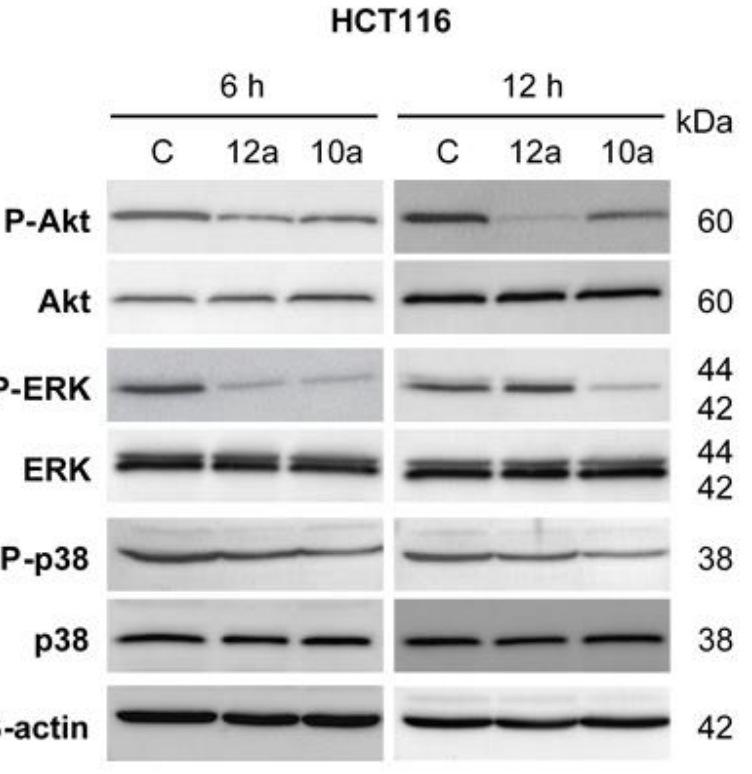
Figure 5. Effects of compounds 10a and 12a on MAP Kinases-related protein expression in human CRC HCT116 cells. β -actin was used as a loading control. Blots shown are representative of three separate experiments.